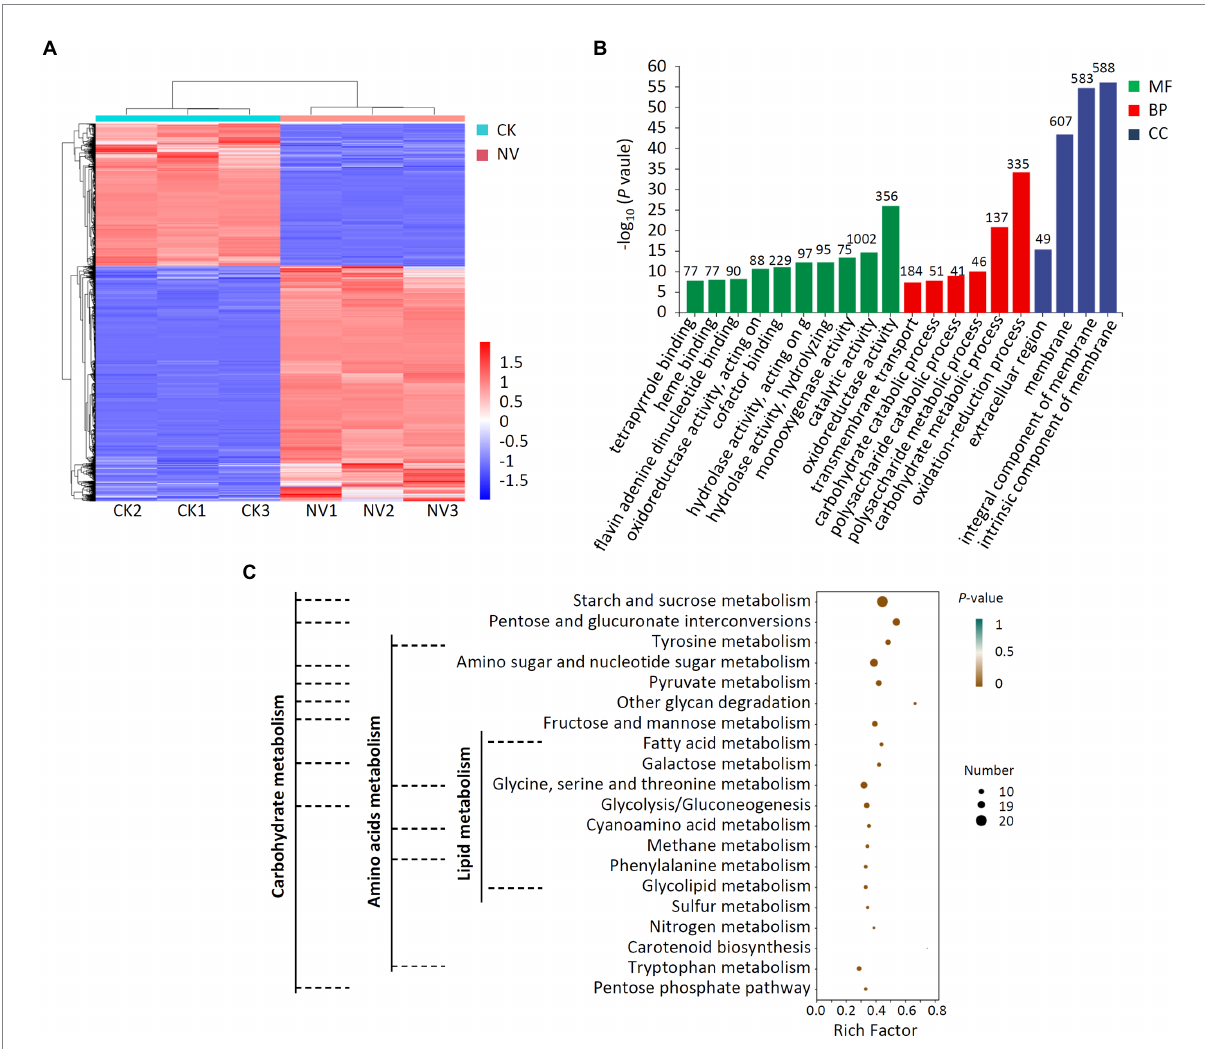
FIGURE 7 Transcriptome analysis of DEGs in V. pyri treated with P. polymyxa strain Nl4. (A) Heat map analysis. CK, untreated V. pyri ; NV, strain Nl4 treated V. pyri . Red indicates highly expressed genes, and blue indicates low expressed genes. (B) GO annotation analyses of DEGs. The number above the column represents the number of DEGs. (C) KEGG pathway enrichment analyses of the DEGs. Rich factor = DEGs number/total gene number identified from transcriptome of a certain